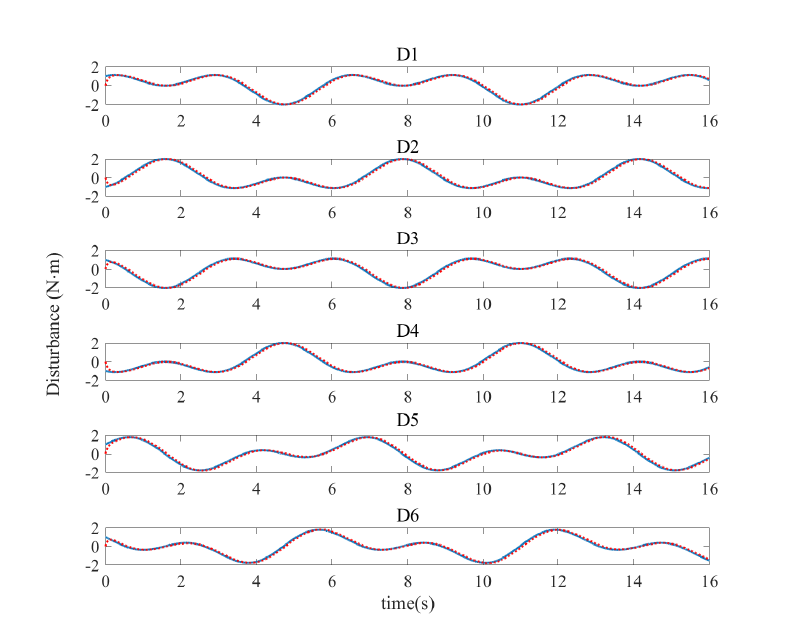
Figure 6. Estimation of the disturbance under the disturbance observer. (Blue: the actual disturbance; Red: the estimated